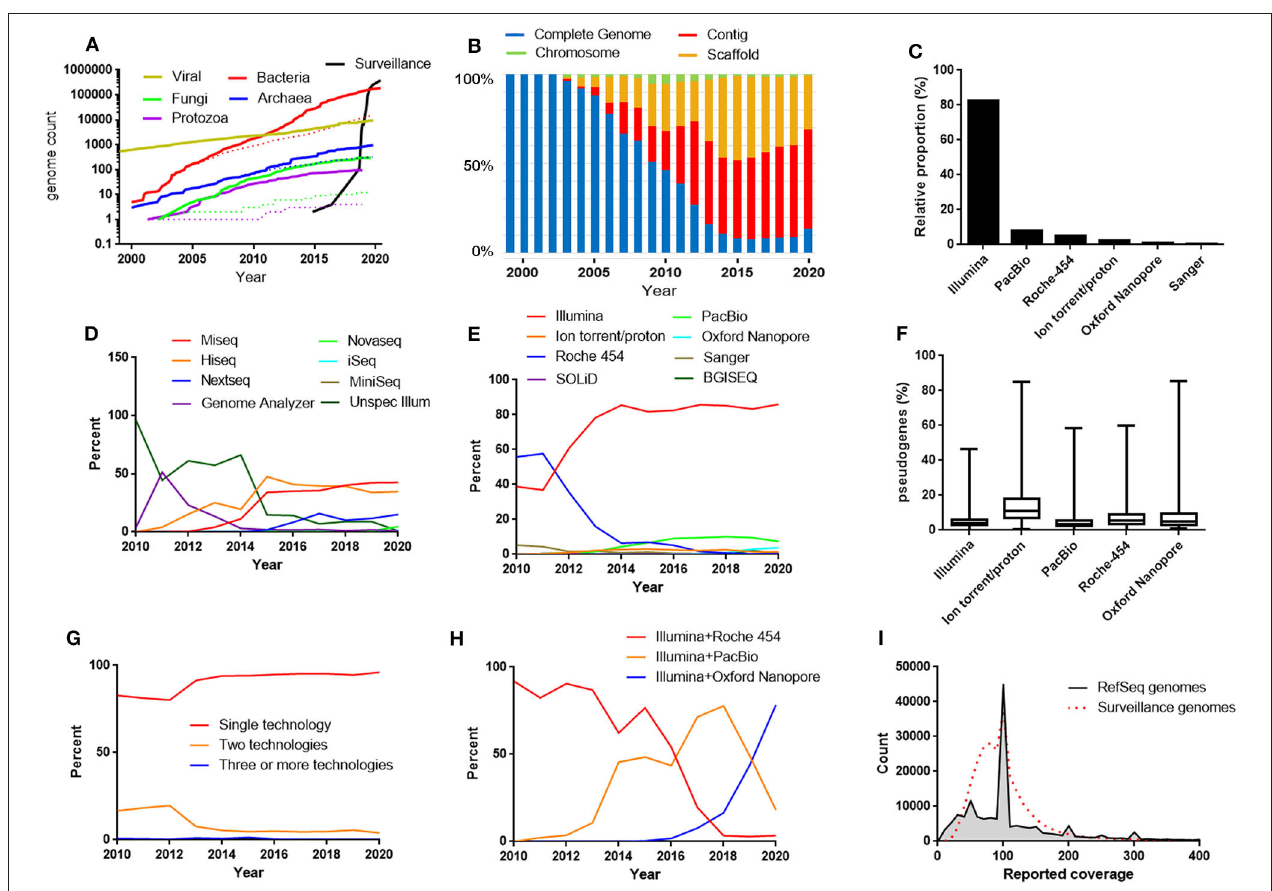
FIGURE 1 | (A) The growth of the RefSeq microbial genomic databases and the database of bacterial genomes excluded from RefSeq for the reason “derived from surveillance project.” Dotted lines represent number of “complete genomes.” The data for 2020 includes genomes submitted before April 17. (B) Relative proportions between the different assembly levels in the bacterial RefSeq genome database. (C) The most frequently used sequencing techniques in the bacterial RefSeq database. (D) Relative proportions between the different Illumina platforms in the bacterial RefSeq genome database. (E) Relative proportions between sequencing techniques used in bacterial RefSeq divided by years. (F) Frequencies of pseudogenes in bacterial RefSeq genomes reported to be produced by one technique alone. (G) Relative proportions between genomes produced by a single sequencing technique and combinations of techniques. (H) Relative proportions between the most frequently used combinations of sequencing techniques in the bacterial RefSeq genome database. (I) Histogram of the reported sequence depth (coverage) used in the bacterial RefSeq genome database and in the bacterial surveillance project genome